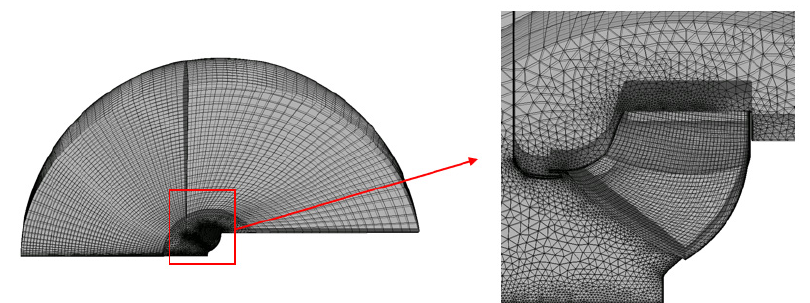
Figure 6. Computational domain.